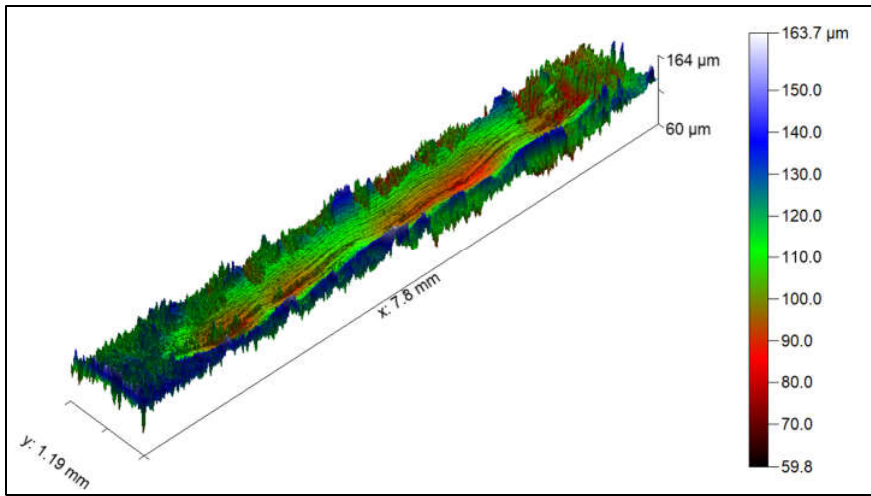
Figure 13. 3D image of the tribological wear track on FSPed composites during the reciprocation ball-on-plate wear test.